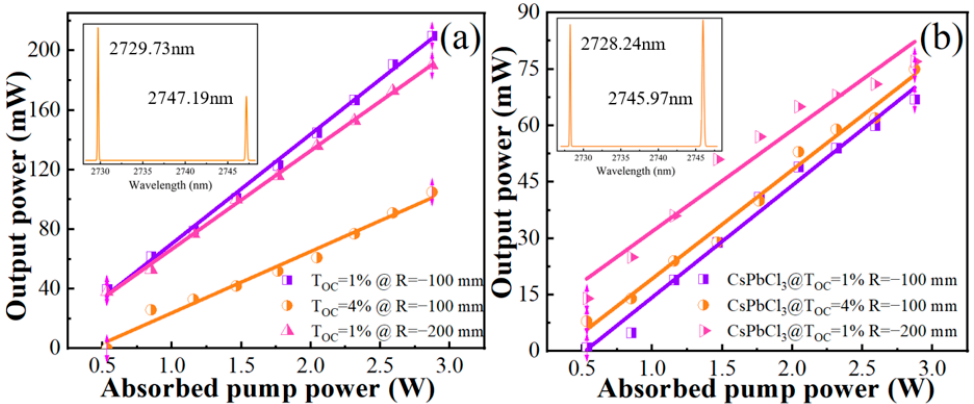
Figure 3. ( a ) Average output power of CW laser; ( b ) average output power of Q-switched laser. Insert laser emission spectrum.